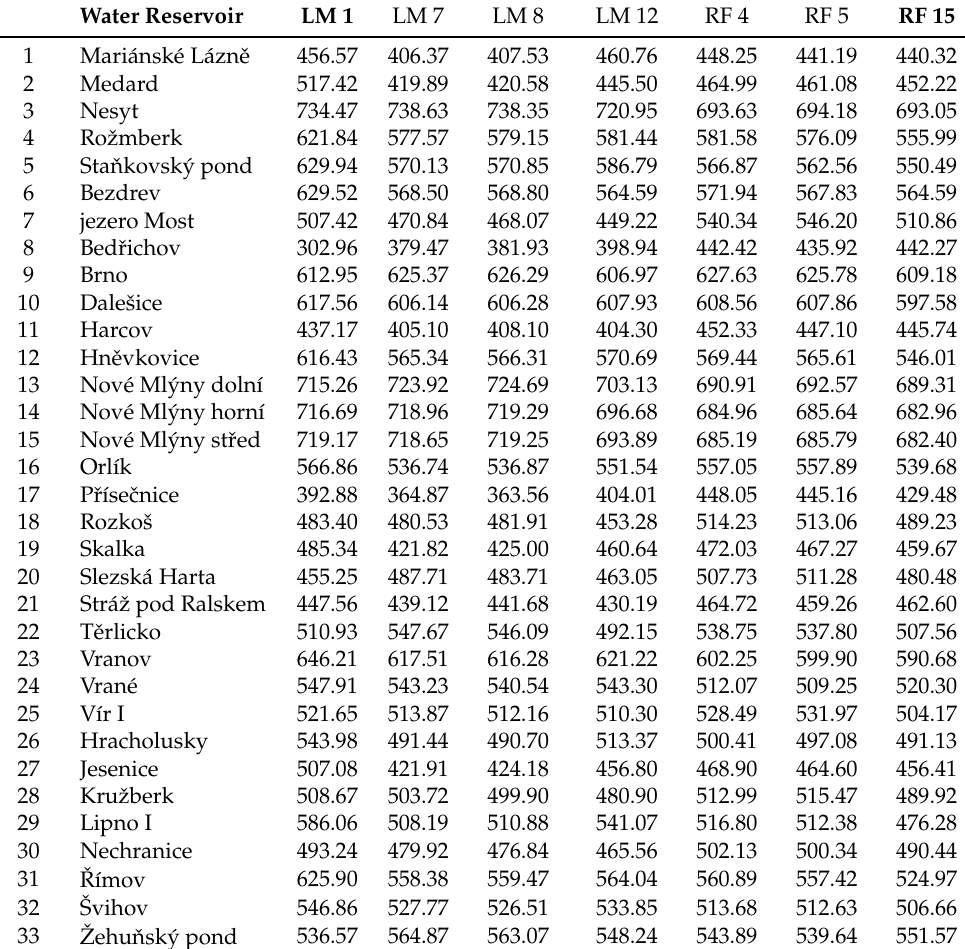
Table A2. Average year evaporation [mm · year − 1 ] values for selected reservoirs by